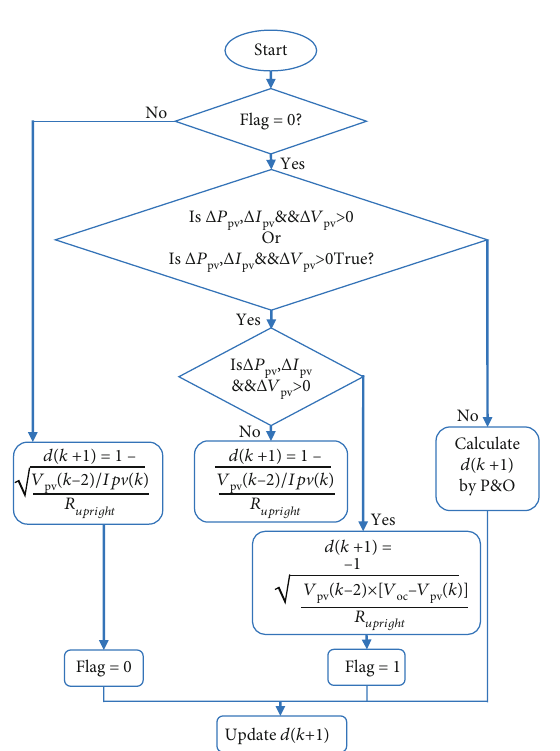
Figure 7: Flowchart of the modi fi ed MPPT method based on the MPP-Locus technique.